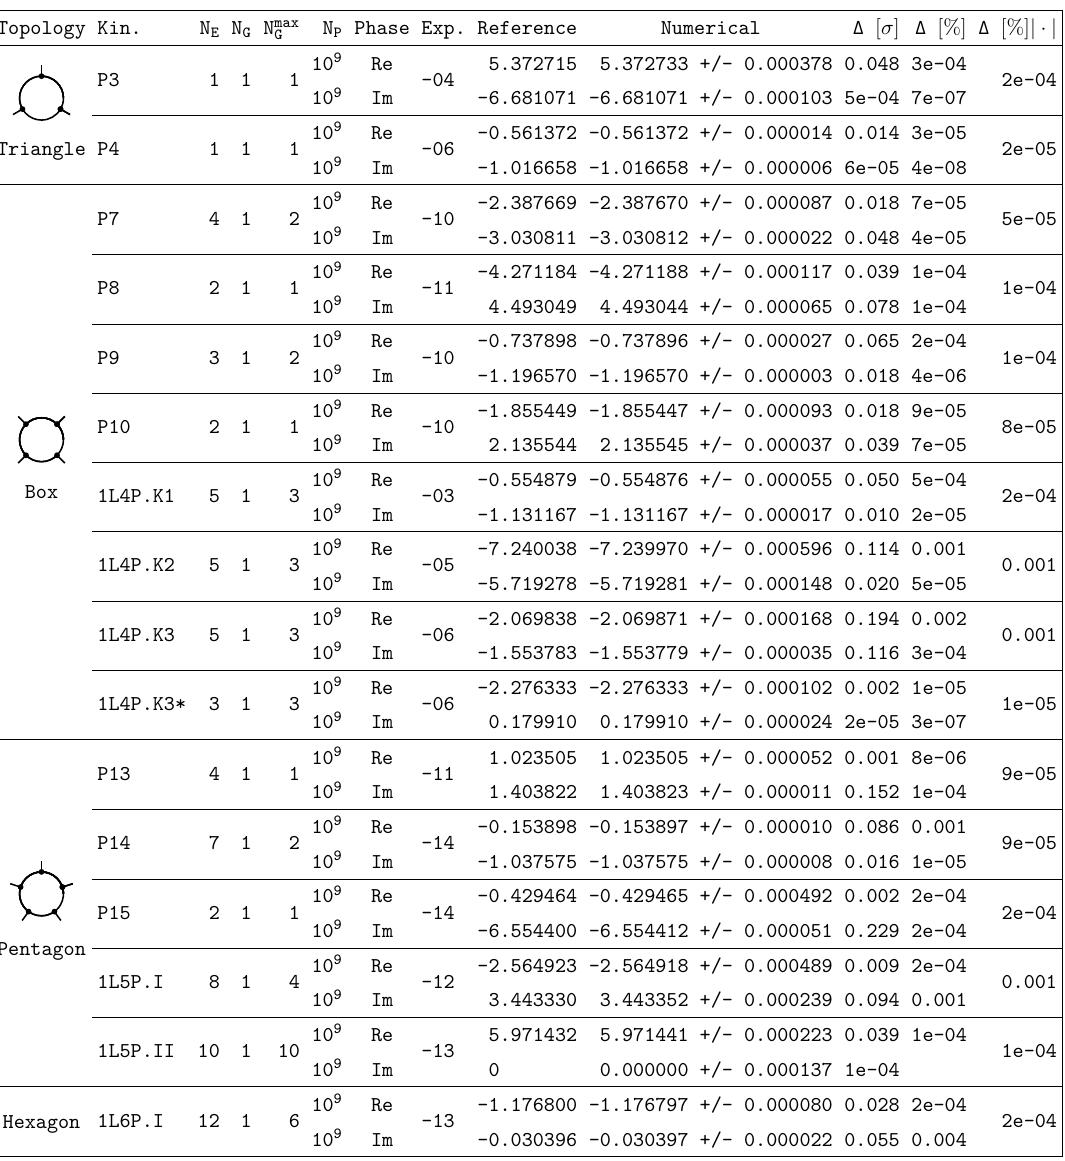
Table 2. Scalar one-loop integrals for various kinematic configurations that allow for the direct application of eqs. (3.31) and (3.32), without the need of grouping residues and counterterms. Here, it was possible to place the origin in the interior of all E-surfaces such that no integrable singularities were introduced to the